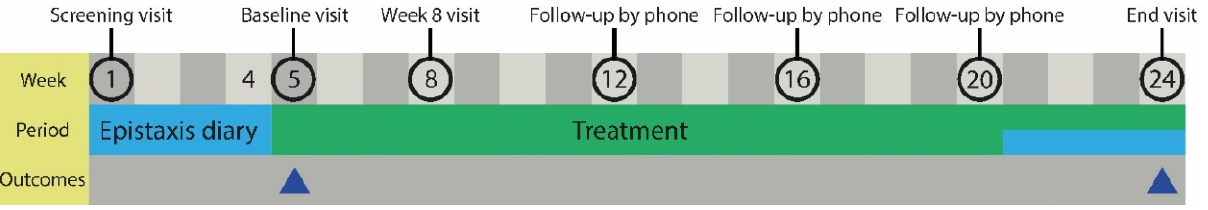
Figure 1. Schematic of the study schedule. The primary and secondary outcomes were measured at baseline and the end visit (blue arrowhead).